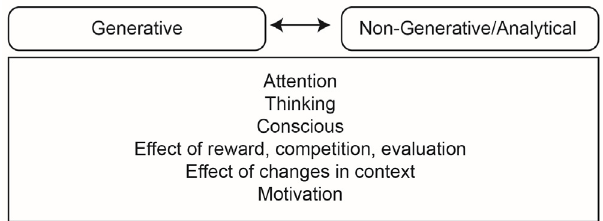
Figure 5. Howard-Jones’s model.